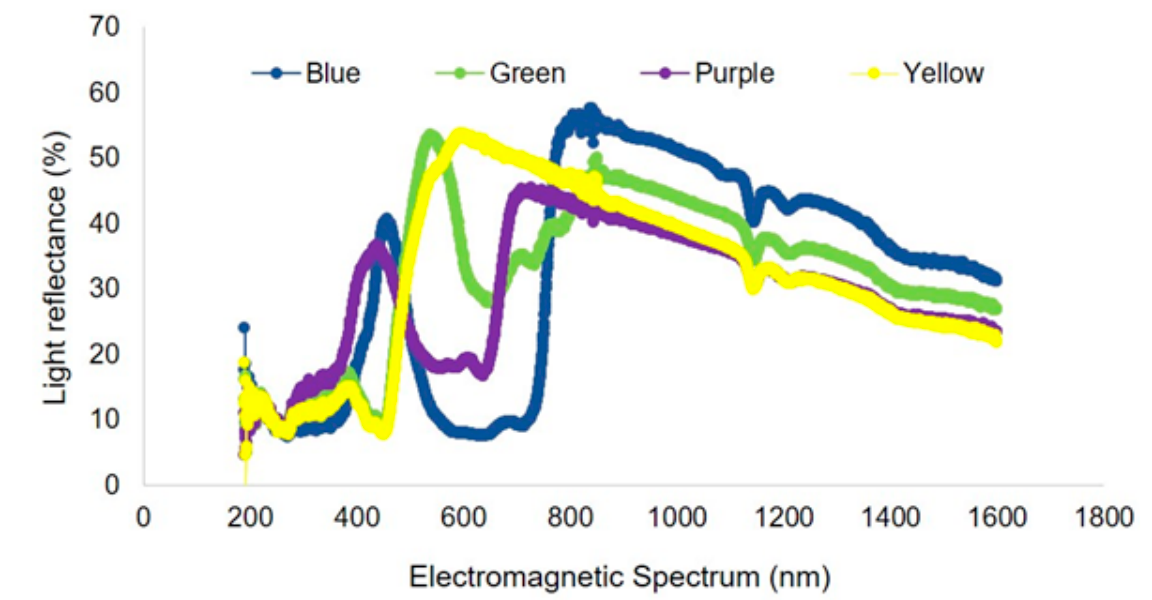
Figure 5. Light reflectance spectrum for four different colors of pan traps used for sampling pollinators and other insect communities.